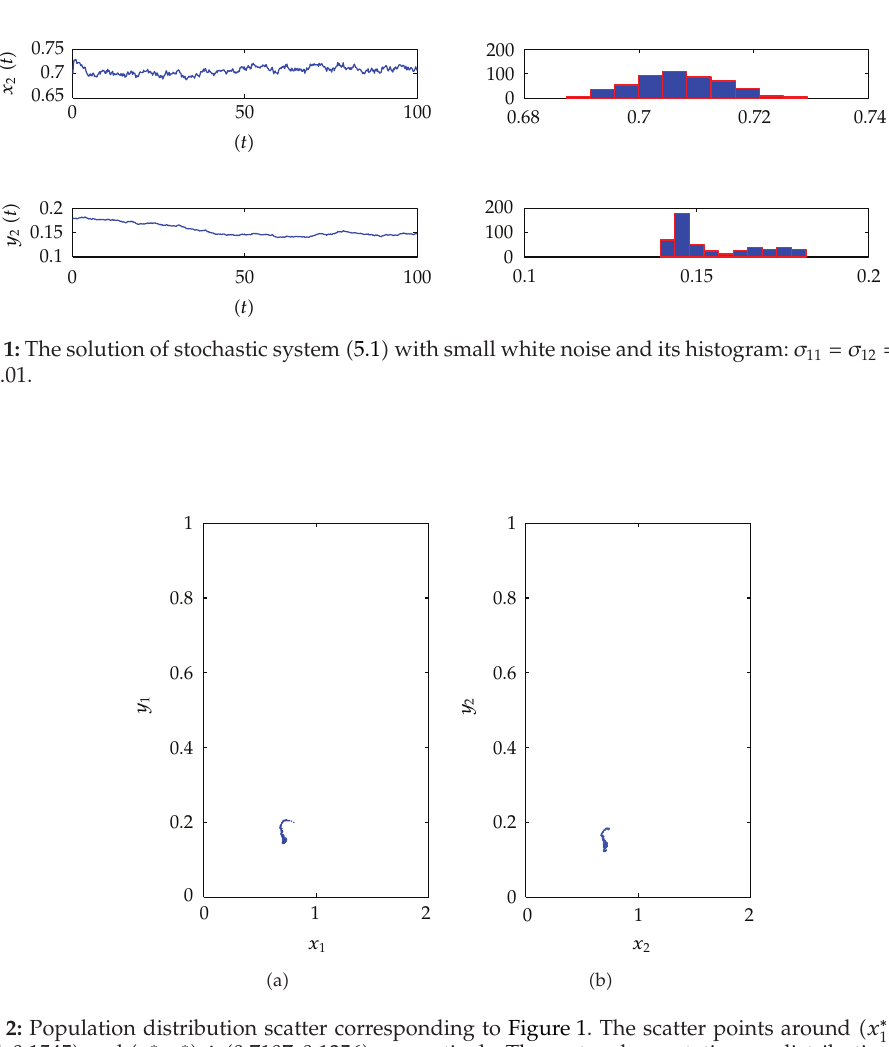
(cid:3) . (cid:5) (cid:2) 0 . 7107 , 0 . 1356 (cid:3) , respectively. The system has a stationary ,y ∗ 2 2